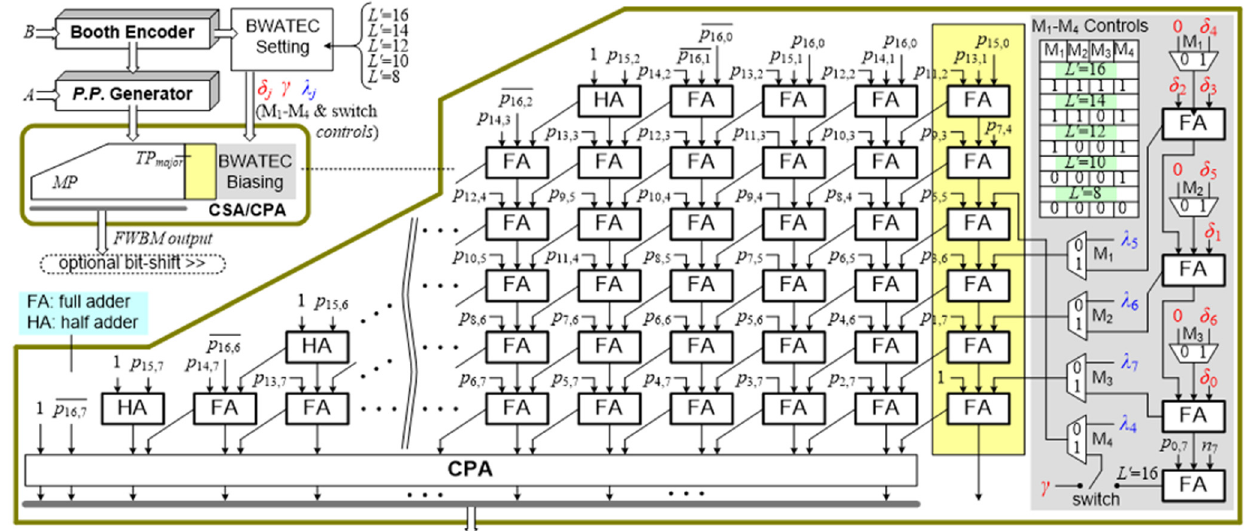
Figure 7. Hardware architecture of 16-bit FWBM that uses the proposed BWATEC scheme.